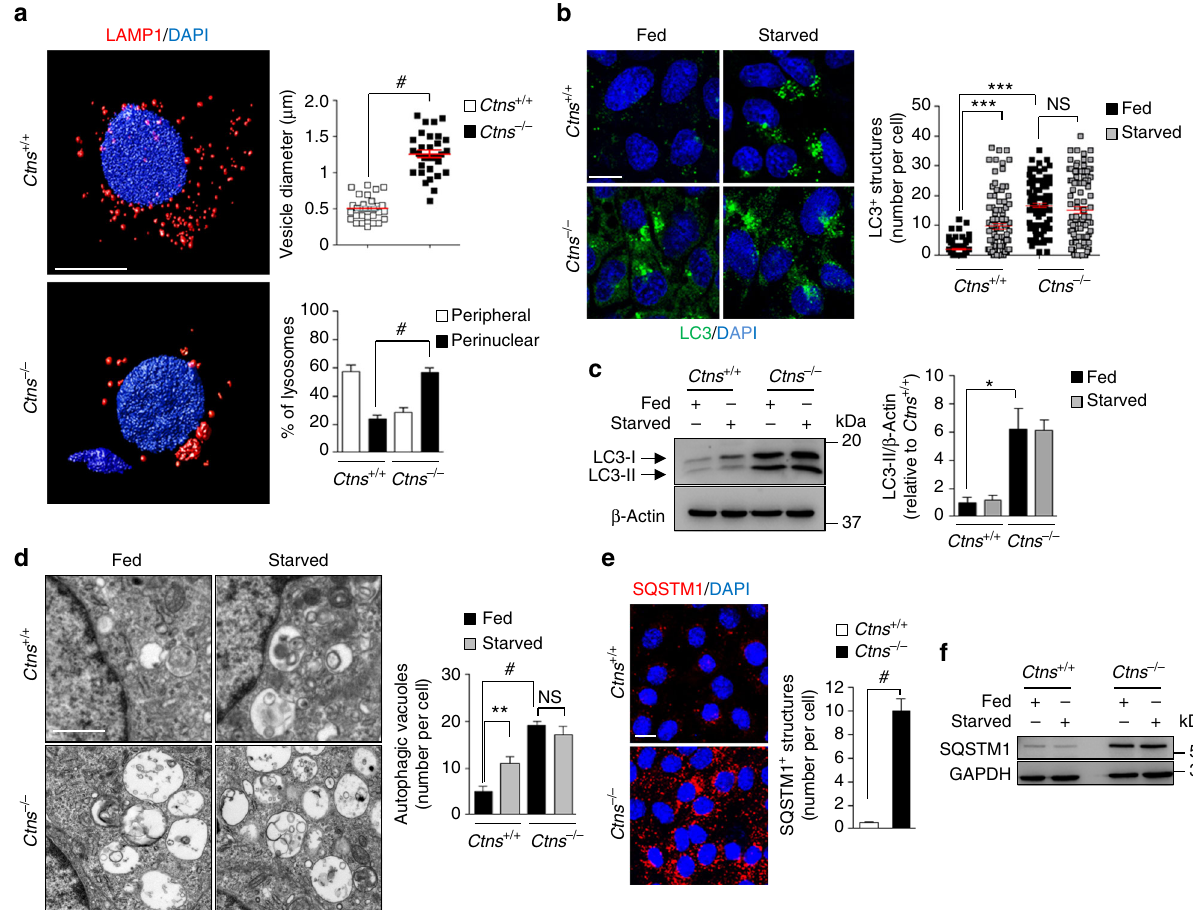
Fig. 1 Abnormal lysosome dynamics and autophagy in CTNS-de fi cient PT cells. a Left: confocal microscopy and three-dimensional (3D) reconstruction of Ctns mPTCs labeled with anti-LAMP1 (red) antibody. Right: quanti fi cation of changes in vesicle size (top, each point representing the average size of LAMP1 + vesicles in a cell) and lysosome positioning (bottom, percent of perinuclear or peripheral distribution) ( n = 30 cells pooled from 3 Ctns kidneys per group; two-tailed unpaired t -test, # P < 0.0001 relative to Ctns + / + mPTCs). b – f Ctns mPTCs were cultured in normal growth (Fed; 8 h) or nutrient-deprived cell medium (Starved; 8 h). b Representative confocal micrographs (left) and quanti fi cation (right) of numbers of LC3 + structures (green) in Ctns mPTCs ( n = 100 cells pooled from three Ctns kidneys per group; each point representing the number of LC3 + vesicles in a cell; one-way analysis of variance (ANOVA) followed by Bonferroni ’ s posthoc test, *** P < 0.001 relative to Ctns + / + mPTCs under fed conditions; NS, not signi fi cant.). c Western blotting and densitometric analyses of LC3 protein levels. β -Actin was used as a loading control. Two-tailed unpaired Student ’ s t -test, * P < 0.05 relative to Ctns + / + mPTCs under fed conditions, n = 3 independent experiments. d Representative electron micrographs (left) and quanti fi cation (right) of numbers of autophagic vacuoles per cell ( n = 10 micrographs per each condition; one-way ANOVA followed by Bonferroni ’ s posthoc test, ** P < 0.01 and # P < 0.0001 relative to Ctns + / + mPTCs under fed conditions; NS, not signi fi cant). e Representative confocal micrographs and quanti fi cation of SQSTM1 + structures (red) in Ctns mPTCs ( n = 100 cells pooled from three Ctns kidneys per group; two-tailed unpaired Student ’ s t -test, # P < 0.0001 relative to Ctns + / + mPTCs). f Representative western blotting of SQSTM1 in Ctns mPTCs. GAPDH was used as a loading control, n = 3 independent experiments. Plotted data represent mean ± SEM. Nuclei are counterstained with DAPI (blue). Scale bars are 10 μ m in a , b , and e , and 2 μ m in d . Unprocessed scans of original blots are